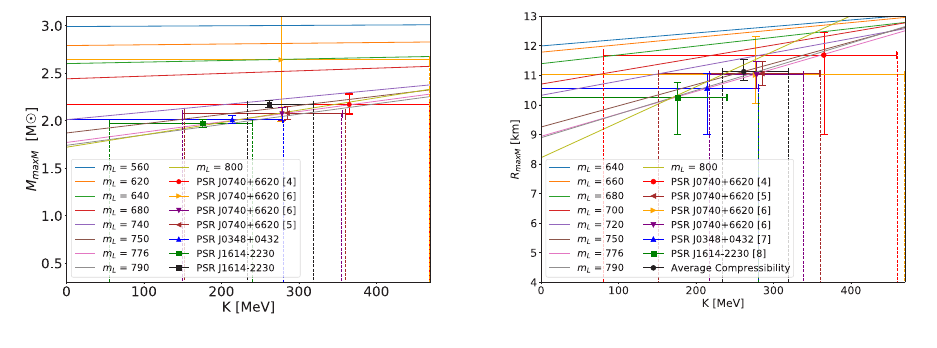
Figure 1. Left panel: mass of the maximal mass star, M maxM ( m L , K ). Right panel: radius of the maximal mass star, R maxM ( m L , K ). Curves at both panels are as function of K at various physical m L values, denoted as color lines. Comparison to pulsar data of PSR J0740 + 6620 [4–6], PSR J0348 + 0432 [7], and PSR J1614 2230 [8] are also plotted, including theoretical uncertainties and data −